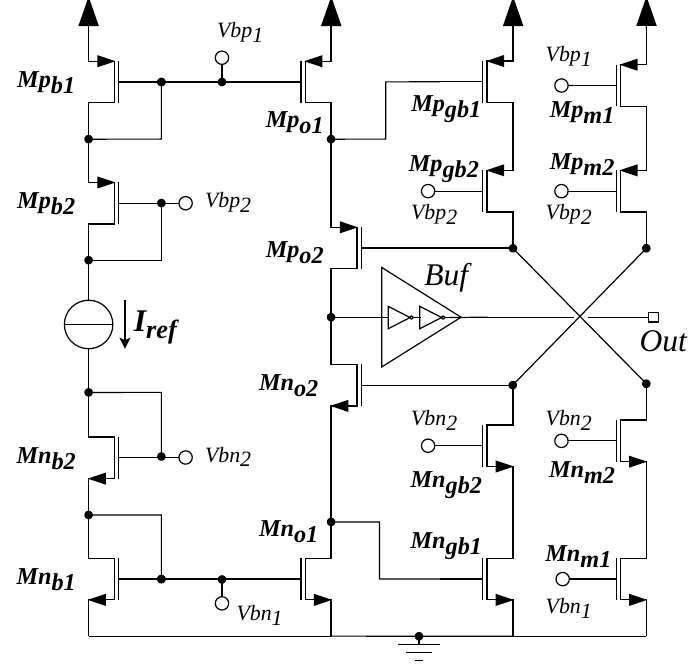
Figure 1. Proposed PUF